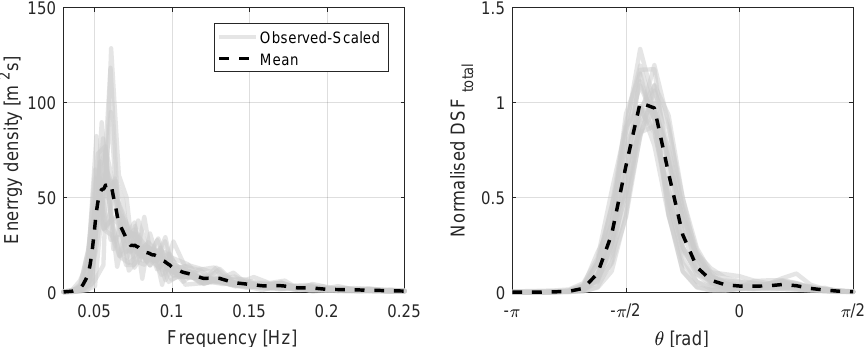
Figure 15. Variation in frequency spectra and DSF’s for high T E example case. 17 spectra from 8 storms shifted onto the desired H m 0 – T E target point 1 defined in Figure 14.